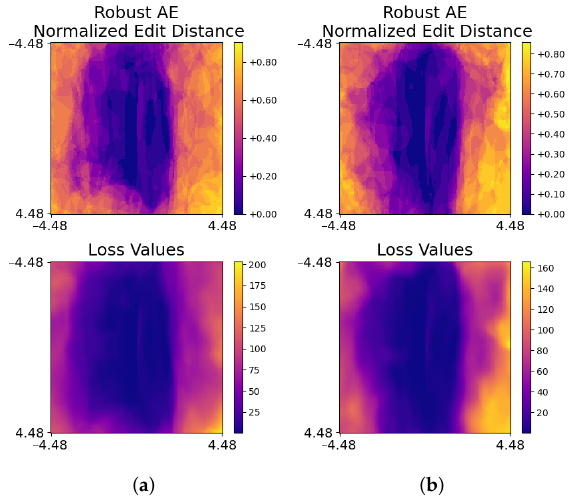
Figure 7. Using different values of p to generate heat maps of loss function values and normalized edit distances for a robust audio AE. Different values of p were used to generate ( a , b